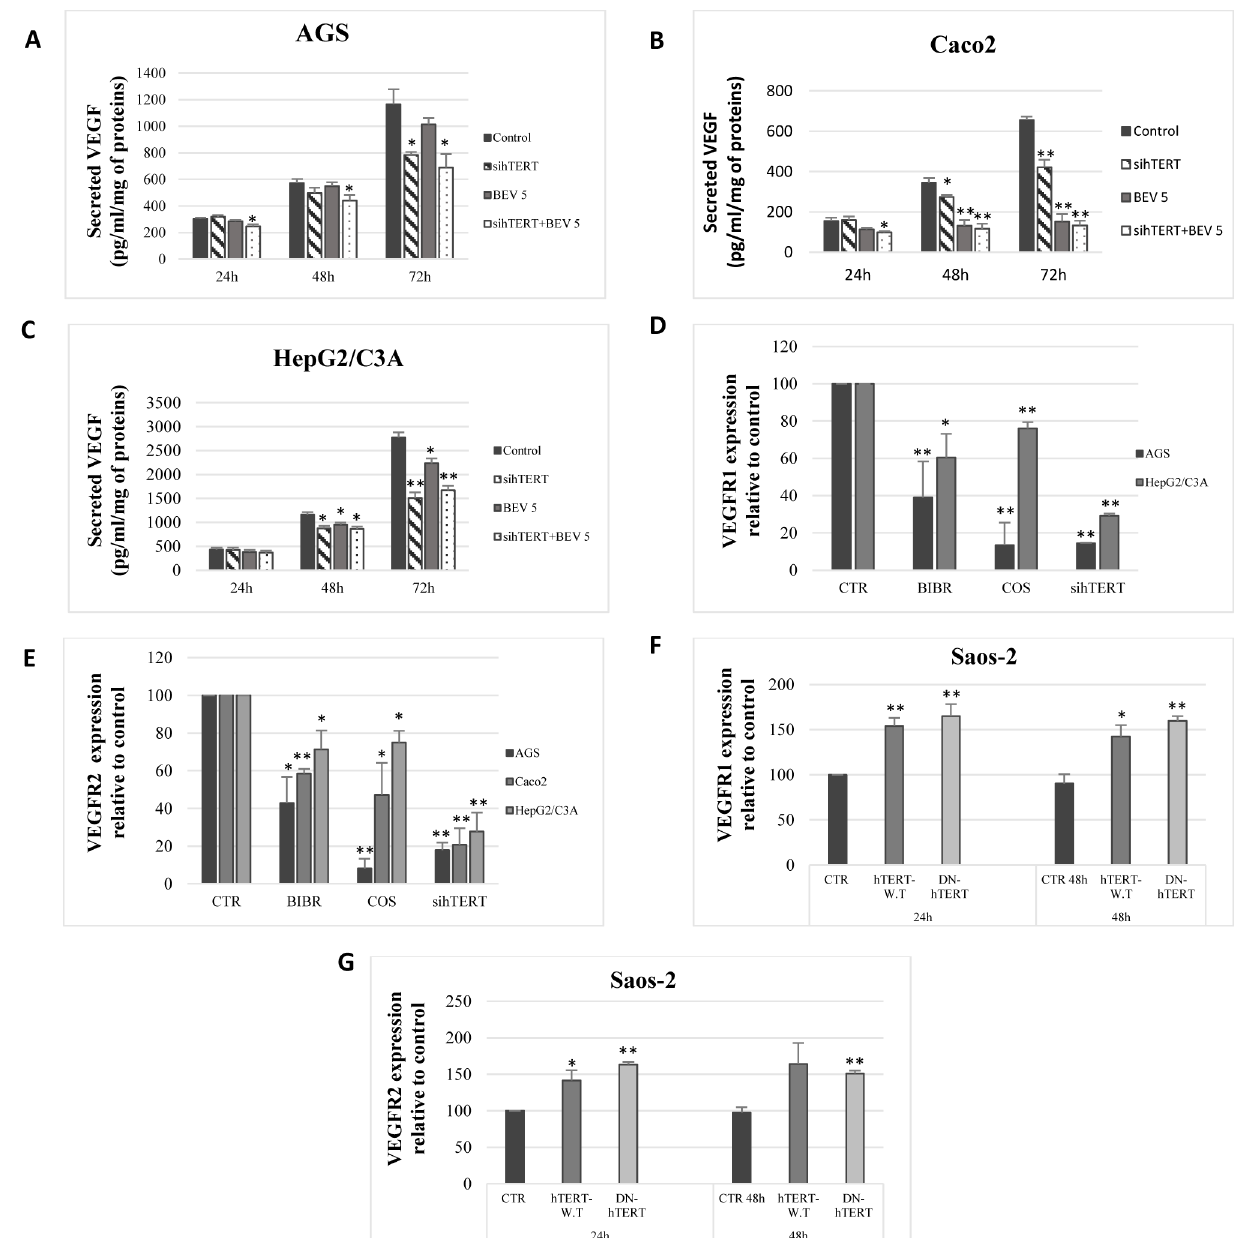
Fig 4. Telomerase regulates VEGF, VEGFR1, and VEGFR2 expression. AGS (A), Caco2 (B), and HepG2/C3A(C) cells were treated with control siRNA or hTERT siRNA with or without bevacizumab, and VEGF secretionwas evaluatedby ELISA. (D, E) Cells were treated with BIBR-1532, costunolide, or transiently transfected with hTERT siRNA for 72h. VEGFR1 (D) and VEGFR2 (E) transcript amounts were quantifiedwith real-time PCR. (F, G) Saos-2 cells were transiently transfected with an empty vector, hTERT-WT or hTERT-DN. VEGFR1 (F) and VEGFR2 (G) were then quantified with real-time PCR. Results were expressedas the mean ± SD from three